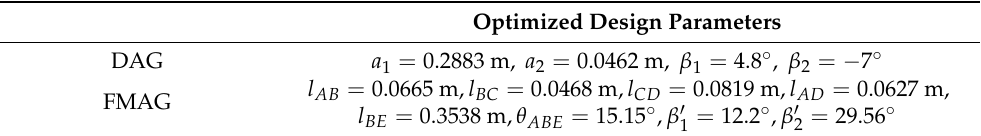
Table 3. Optimized results of the design parameters in the DAG and